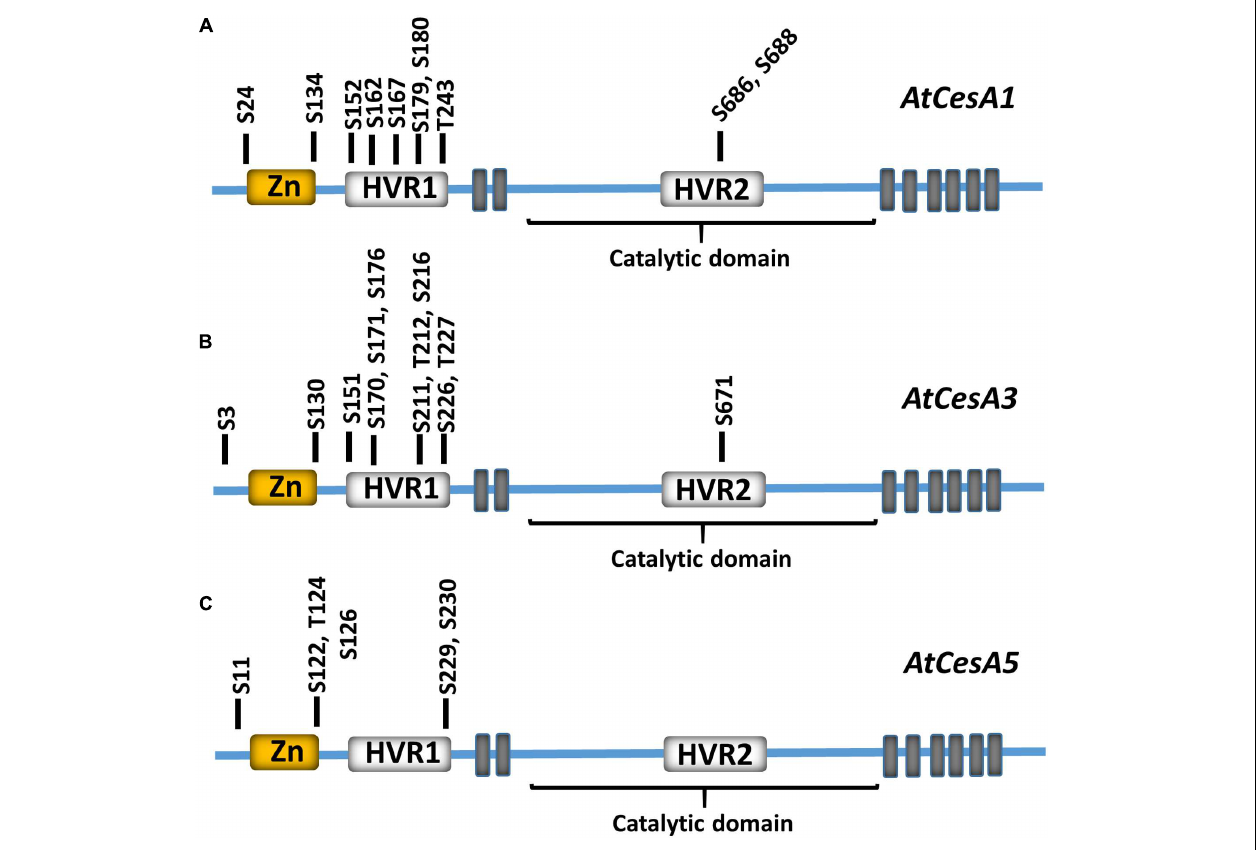
FIGURE 1 | Experimentally supported phosphorylation sites in CESA subunits. Experimentally supported phosphorylation sites in Arabidopsis CESA1 (A) , CESA3 (B) , and CESA5 (C) are shown relative to the CESA N-terminal zinc finger (Zn; yellow), hypervariable 1 and 2 (HVR1 and HVR2; white), and catalytic domains. The residue and corresponding residue number within the primary sequence is shown. The position of predicted CESA transmembrane domains are indicated by gray boxes. These phosphorylation sites are experimentally supported in the PhosPhat 4.0 phosphorylation